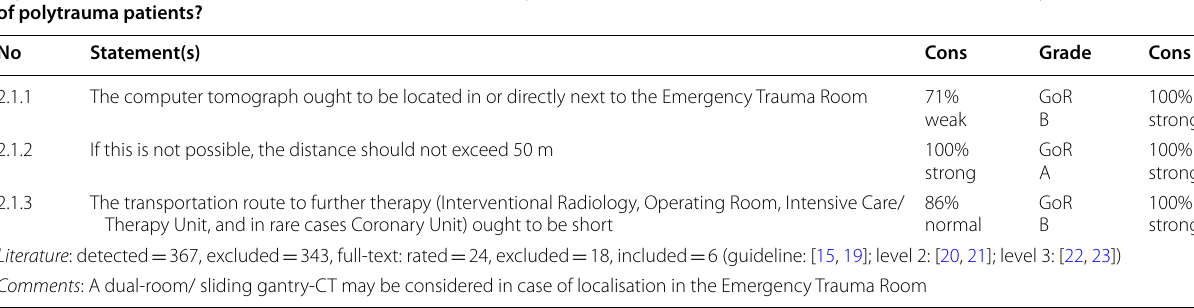
Table 2 Section 2: Structural points, key issue 1: CT location